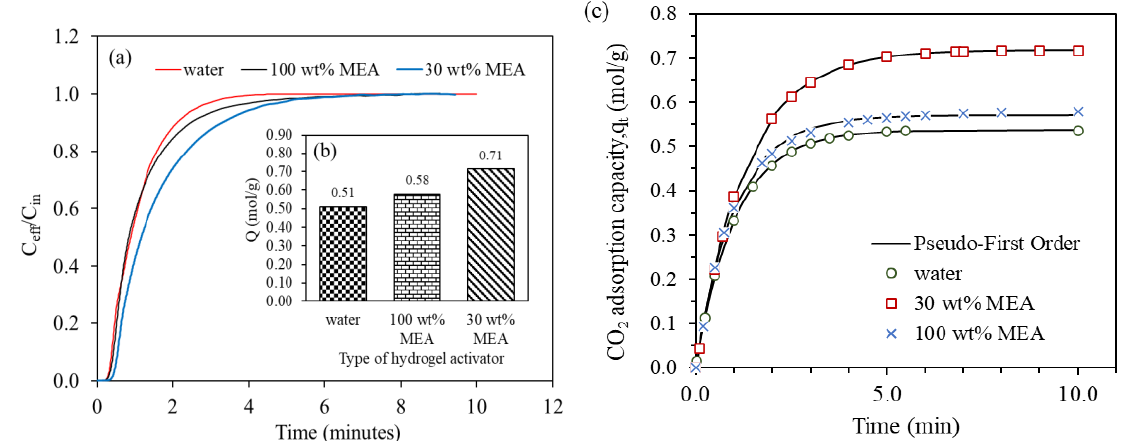
Figure 8. ( a ) Breakthrough adsorption curves, ( b ) equilibrium adsorption capacity and ( c ) pseudo-first order fitted adsorption capacity in the presence of different hydrogel activators (temperature = 30 °C, pressure = 2 bar, CO 2 flowrate = 60 mL/min).